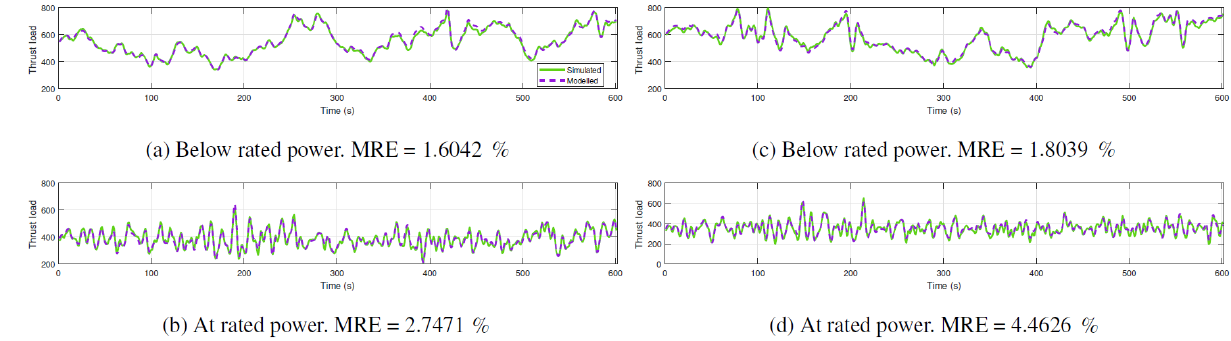
Figure 5. Time series (spanning 10min) of modeled and simulated thrust loads below rated (a, c) and at rated power (b, d) . For each operational state, the time series with the highest averaged absolute error is shown (c, d) . MRE shows the averaged absolute relative error over